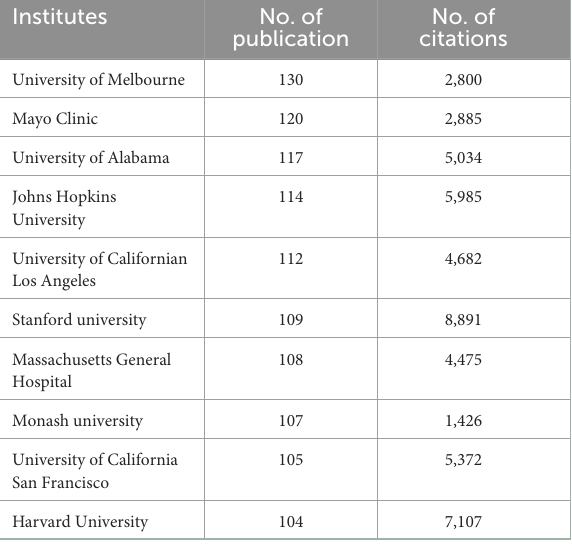
TABLE 3 The top 10 productive